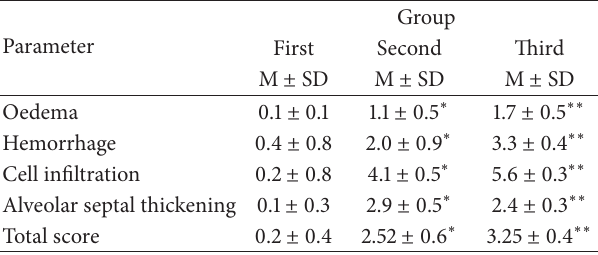
Table2:Comparisonbetweeneffectsofcyclosporinedifferentdoses on the rats’ lung histopathological